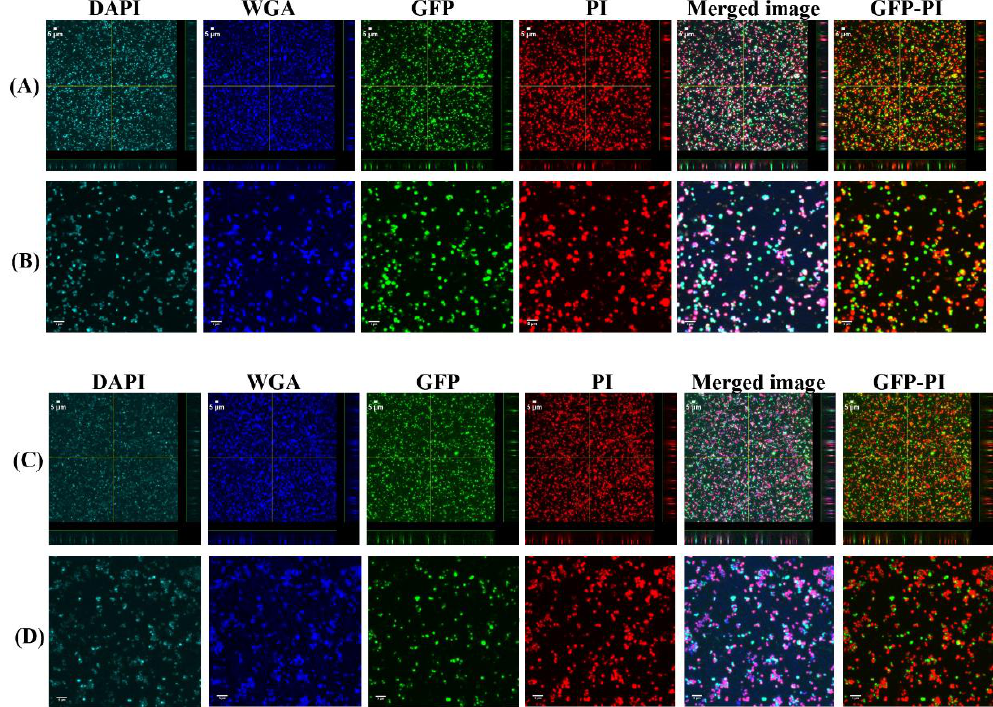
Figure 6. Confocal images of aggregated ( A , B ) and single cells ( C , D ) biofilms for 10 8 CFU/mL after 24 h antibiotic treatment. Panel B and D are zoomed images. Biofilms stained with DAPI for eDNA, WGA stain for PNAG or SF-derived HA, and PI for staining dead cells. Merged images denote the combination of DAPI, WGA, GFP, and PI images. GFP-PI is combination of GFP and PI images.